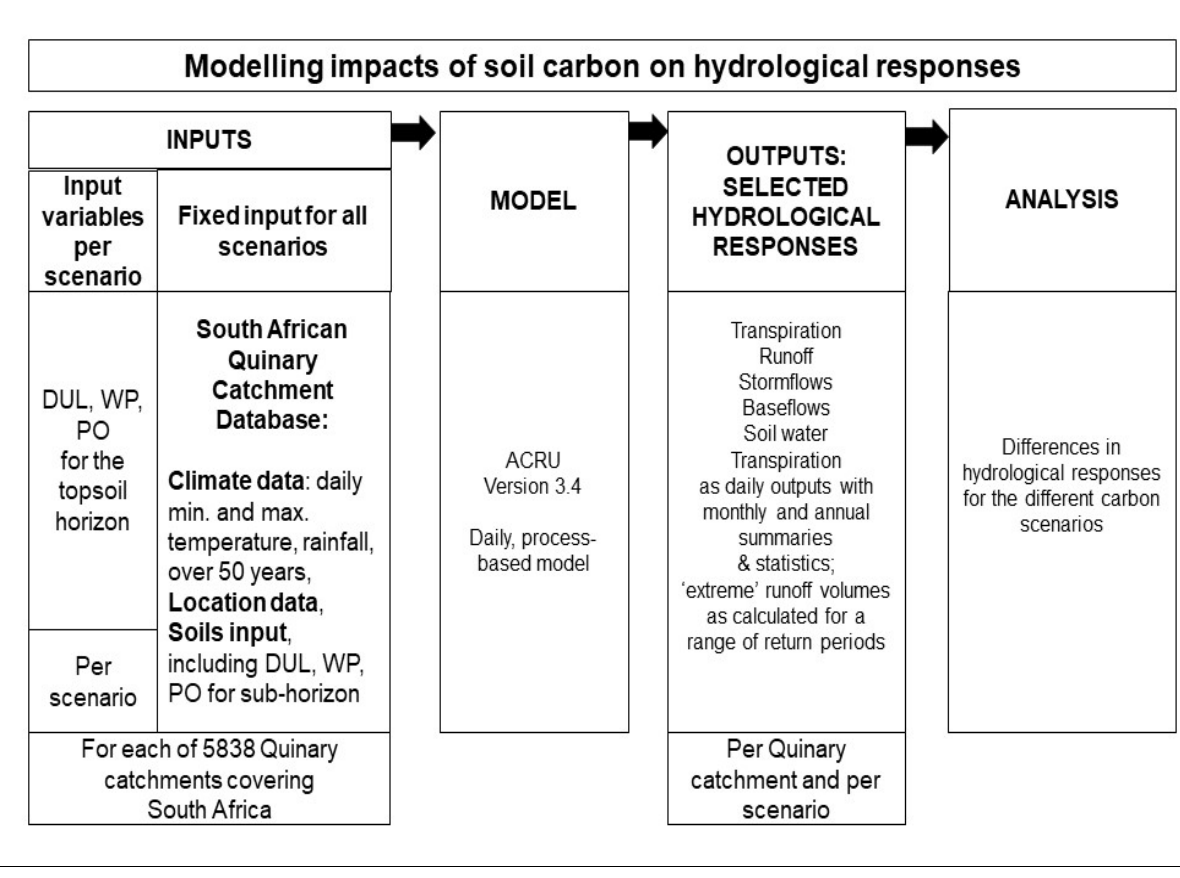
Figure 1: Schematic describing modelling impacts of soil carbon on hydrological